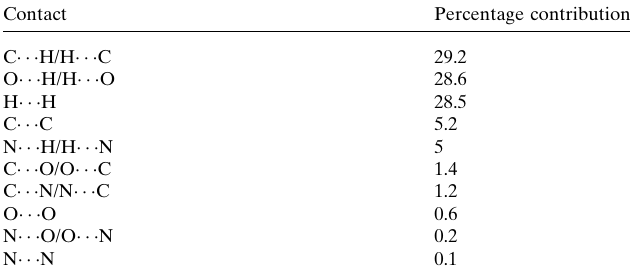
Table 2 Percentage contributions of interatomic contacts to the Hirshfeld surface. Contact